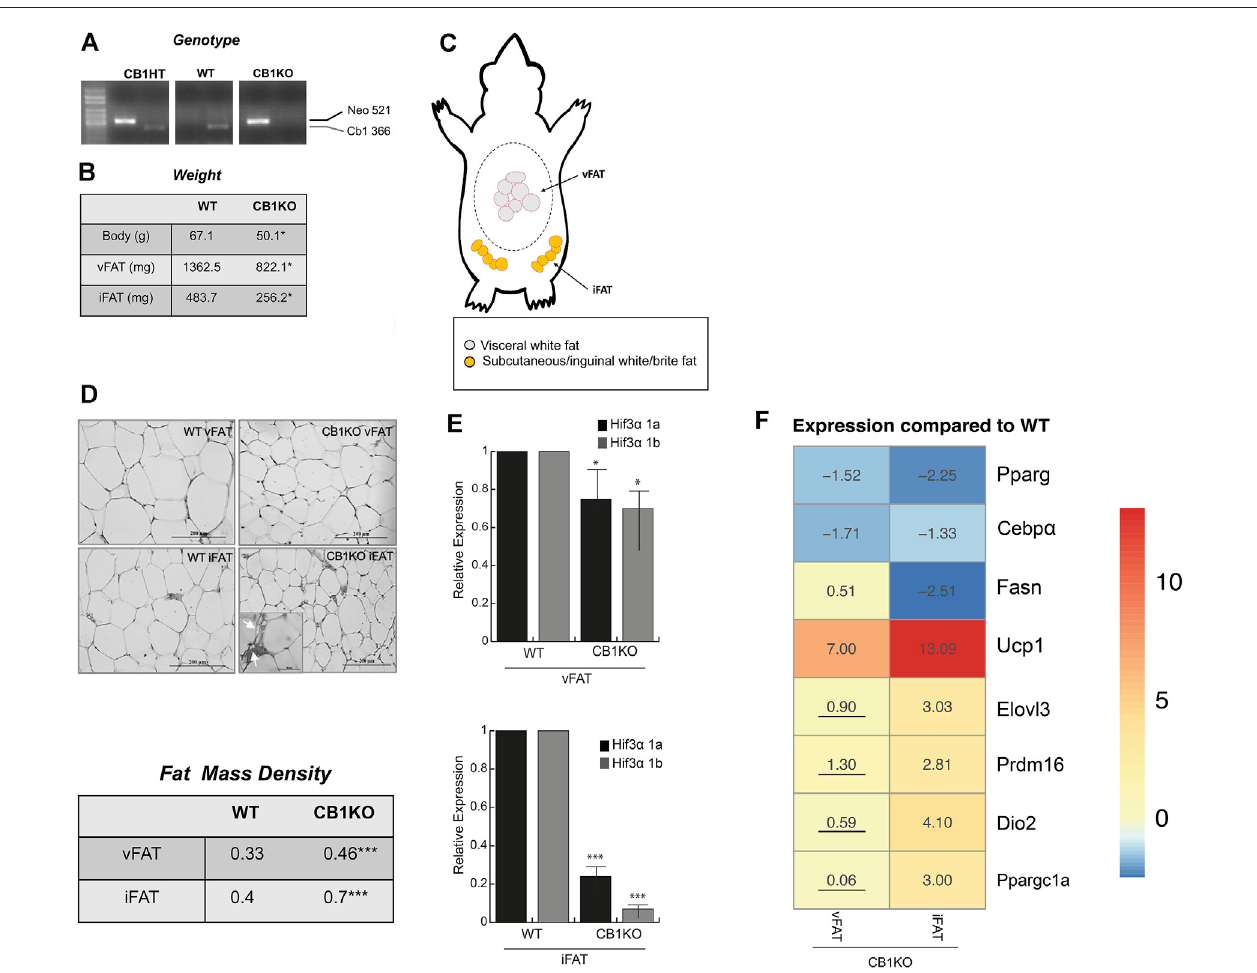
FIGURE 6 | The causal Hif3 α /Ucp1 relation in thermogenesis-induced model. (A) Animal genotyping by PCR analysis of genomic DNA. (B) Animal and fat depots weights (C) Schematic representation of the distribution of adipose tissue depots collected: visceral white fat (vFAT) and inguinal/subcutaneous white fat (iFAT). (D) Representative haematoxylin and eosin-stained of vFAT and iFAT sections (upper panel) and fat cell density (lower panel). (E) Expression levels of Hif3 α isoforms gene by qPCR in vFAT and iFAT of WT and CB1KO mice. Relative gene expression data are reported as 2- ΔΔ Ct, normalized to housekeeping genes (b-actin and 18S mRNA). Data are expressed as means ± SEM ( n (cid:2) 3 animals/genotype, *** p ≤ 0.001, * p ≤ 0.05 vs. WT mouse). (F) Heatmap represents expression pro fi le of WAT-speci fi c ( Pparg, C/ebp α , Fasn ) and BAT-speci fi c genes ( Ucp1, Elovl3, Prdm16, Dio2, Ppargc1a ) in vFAT and iFAT differentially expressed in CB1KO compared to WT. Values represent the means of the fold change vs. WT ( n (cid:2) 3 animals/genotype). All values are signi fi cant ( p < 0.05), except those underlined.